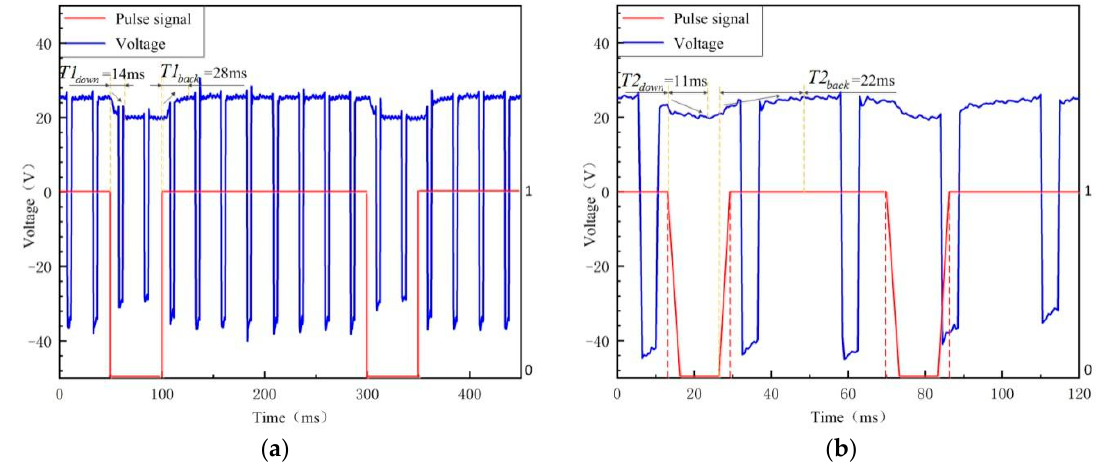
Figure 5. The arc voltage of PPG-VPPAW. ( a ) PPG-VPPAW (4 Hz); ( b ) PPG-VPPAW (20 Hz).